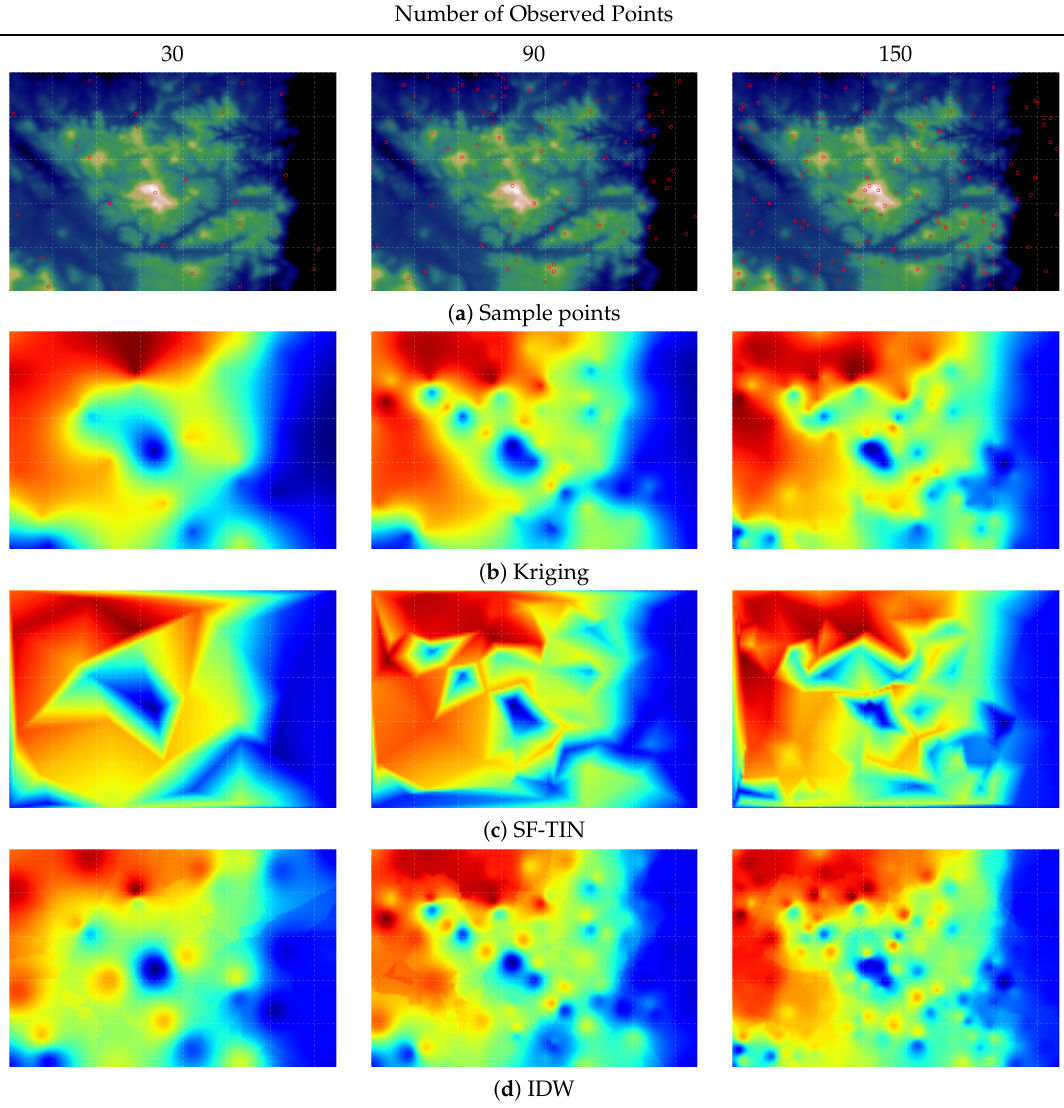
Figure 7. Visualisation output for: the selected sample point locations ( a ) using the optimisation technique (DE); and three widely-used different spatial interpolation techniques ( a ) ordinary kriging, ( b ) triangular irregular network and ( c ) inverse distance weighting], compared to different numbers of sample points ( N = 30, 90, 150). Table 3. Total normalised time elapsed for each method (0: fastest, 1: